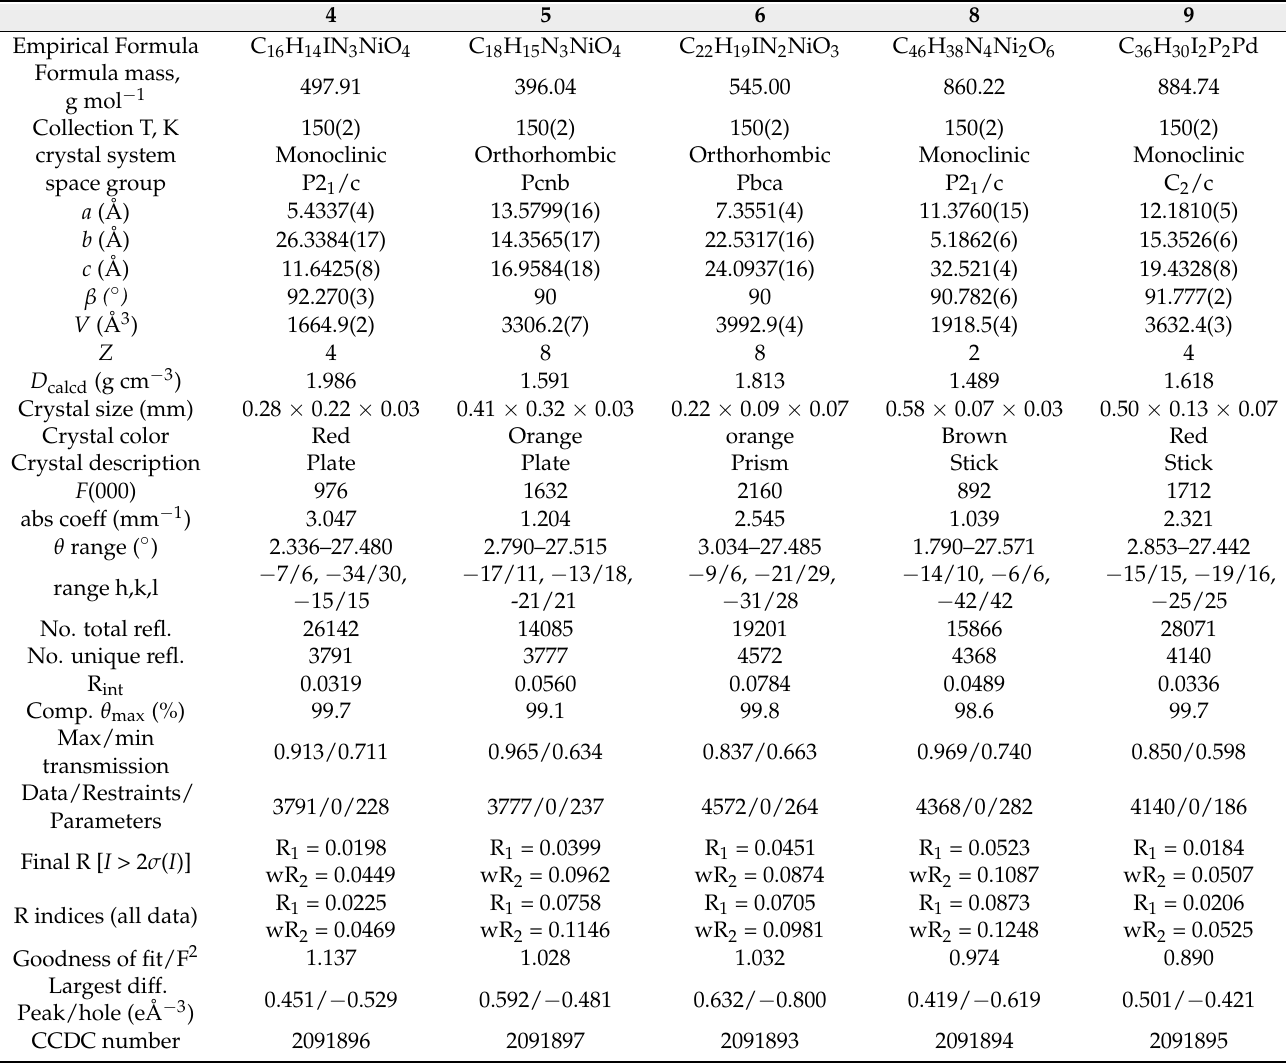
Table 3. Crystal data, details of data collection and structure refinement parameters for compounds 4 , 5 , 6 , 8 and 9